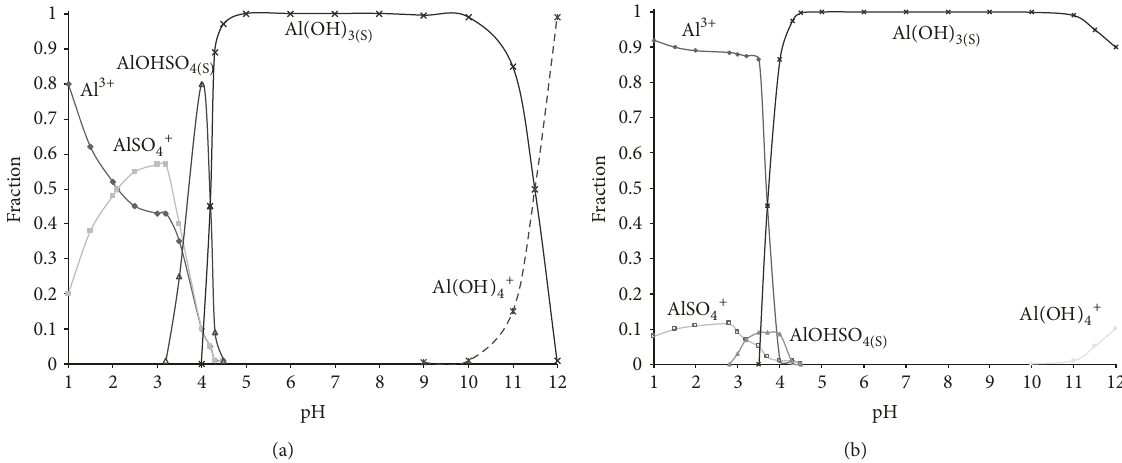
Figure1:(a)SpeciationofpolymorphicAlcomplexescalculatedbyMedusa-HydraintherangeofpHwasof2to12,in5 minoftreatmentwith concentrations of [NO 3− ] 1.29 mM, [SO 42− ] 3.14 mM, and [Al 3+ ] 2 mM. (b) Speciation of polymorphic Al complexes calculated by Medusa- Hydra in a pH range of 2 to 12, in 60min of treatment with concentrations of [NO 3− ] 1.29mM, [SO 42− ] 3.14 mM, and [Al 3+ ] 25 mM.